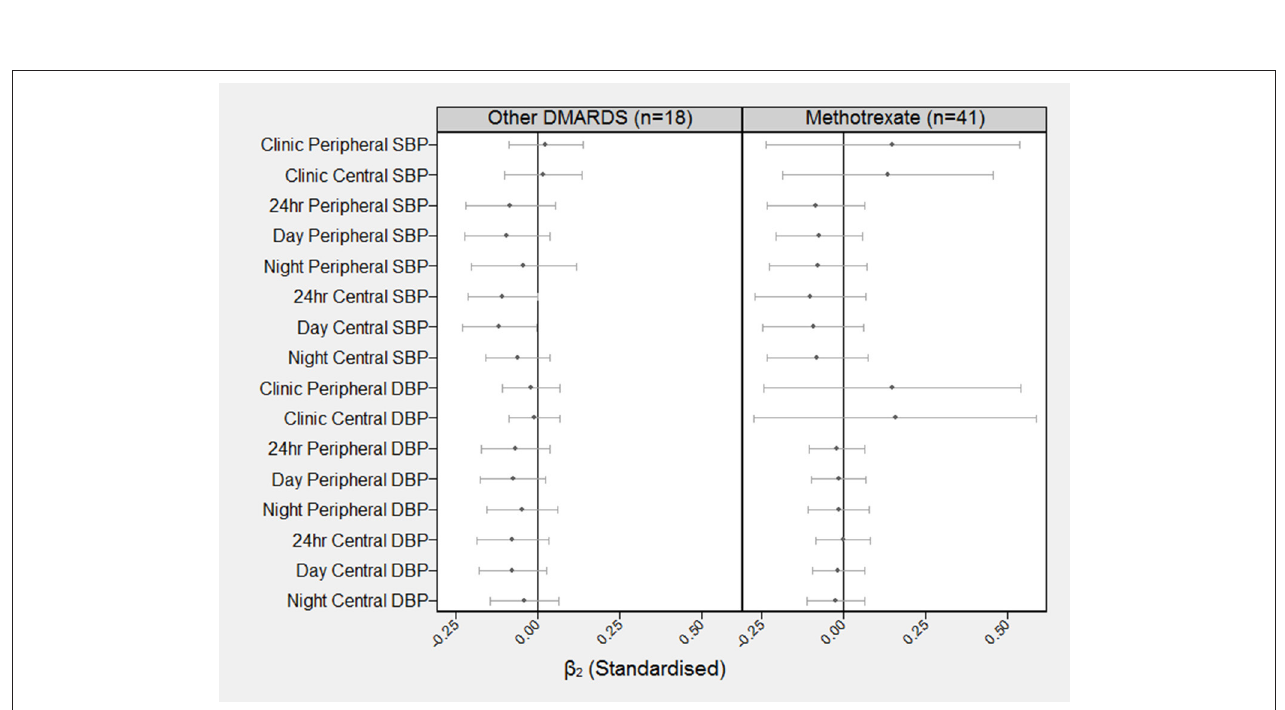
FIGURE 3 | Standardized coefficients (and 99.7% confidence intervals) describing the correlation between baseline BP at follow-up PWV ( β 2 ). The standardized β 2 can be interpreted as the number of SD increases in PWV at 8 months for each one SD increase in BP at baseline. For example, the standardized β 2 coefficient for baseline BP on clinic peripheral PWV for the other DMARDS group is β 2 = 0.02 (99.7% CI = − 0.09–0.14).